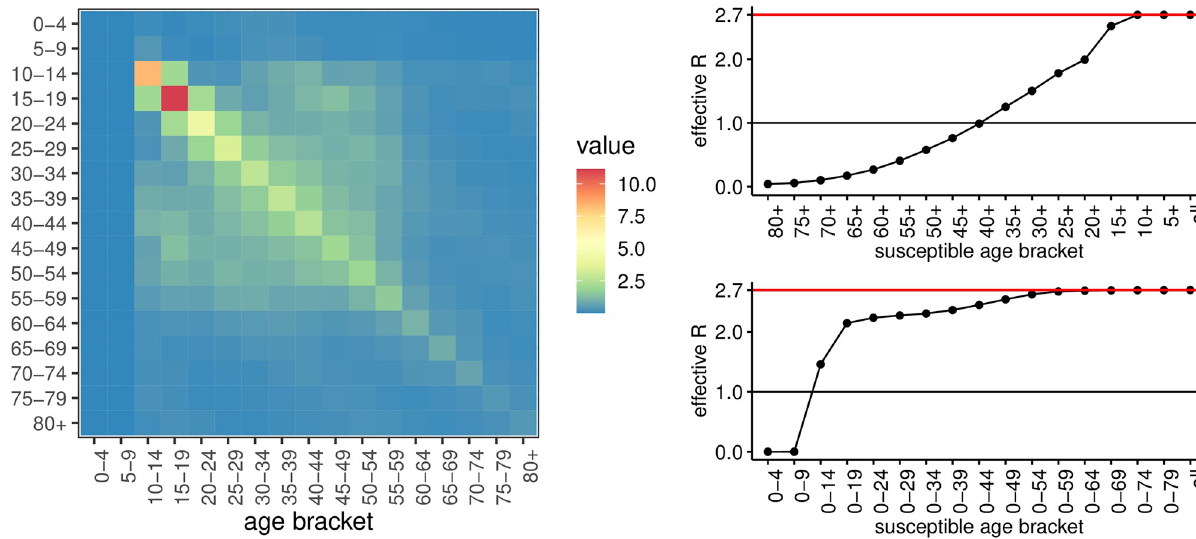
Fig 8. Left : A modified contact matrix for the scenario where children under 10 are 50% less susceptible and 90% less infectious than older age groups. Right : Even after rescaling to correspond to R 0 = 2.7, we see that older age groups are still much less capable of sustaining an epidemic on their own than are younger age